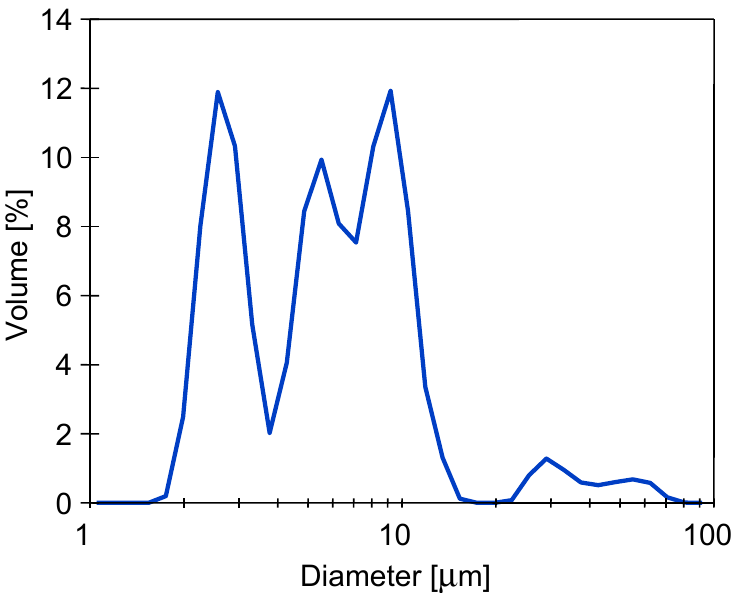
Figure 7. Droplet size distribution of the permeate obtained in MF of the model emulsion (C F = 150